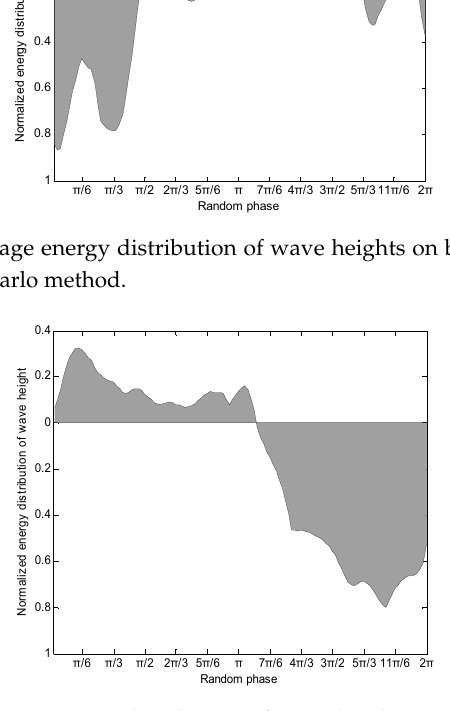
Figure 10. Normalized average energy distribution of wave heights on both sides in the horizontal direction based on Fractal method.